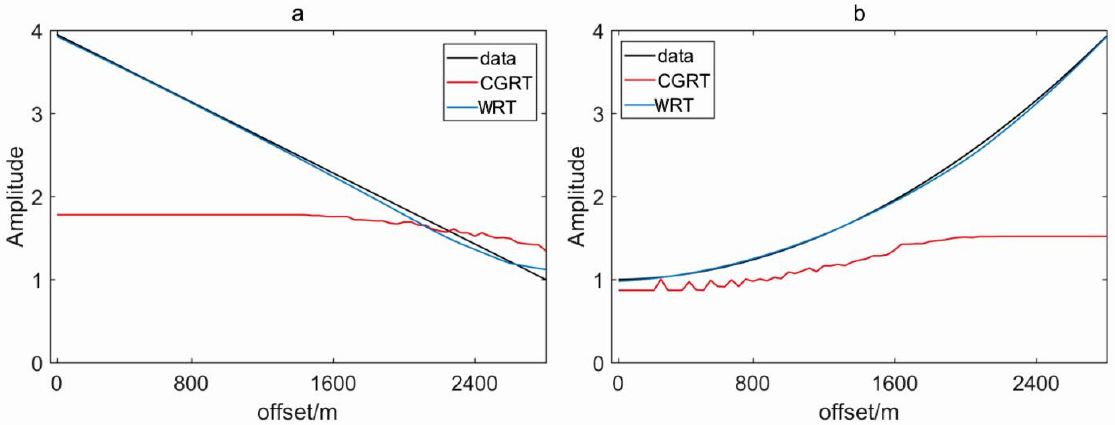
Figure 7. ( a ) AVO of reflection at 500 ms; ( b ) AVO of reflection at 900 ms. Figure 8 shows the waveform of the original data at the first trace and one of the reconstruction traces. The black line represents the original data, the red line and the blue line represent the reconstruction data of the CGRT and WRT, respectively. Compared with the CGRT, the WRT kept an accurate waveform with little error. The waveform error of the WRT increased at the reconstruction trace. However, the WRT still kept an accurate waveform compared with the CGRT.